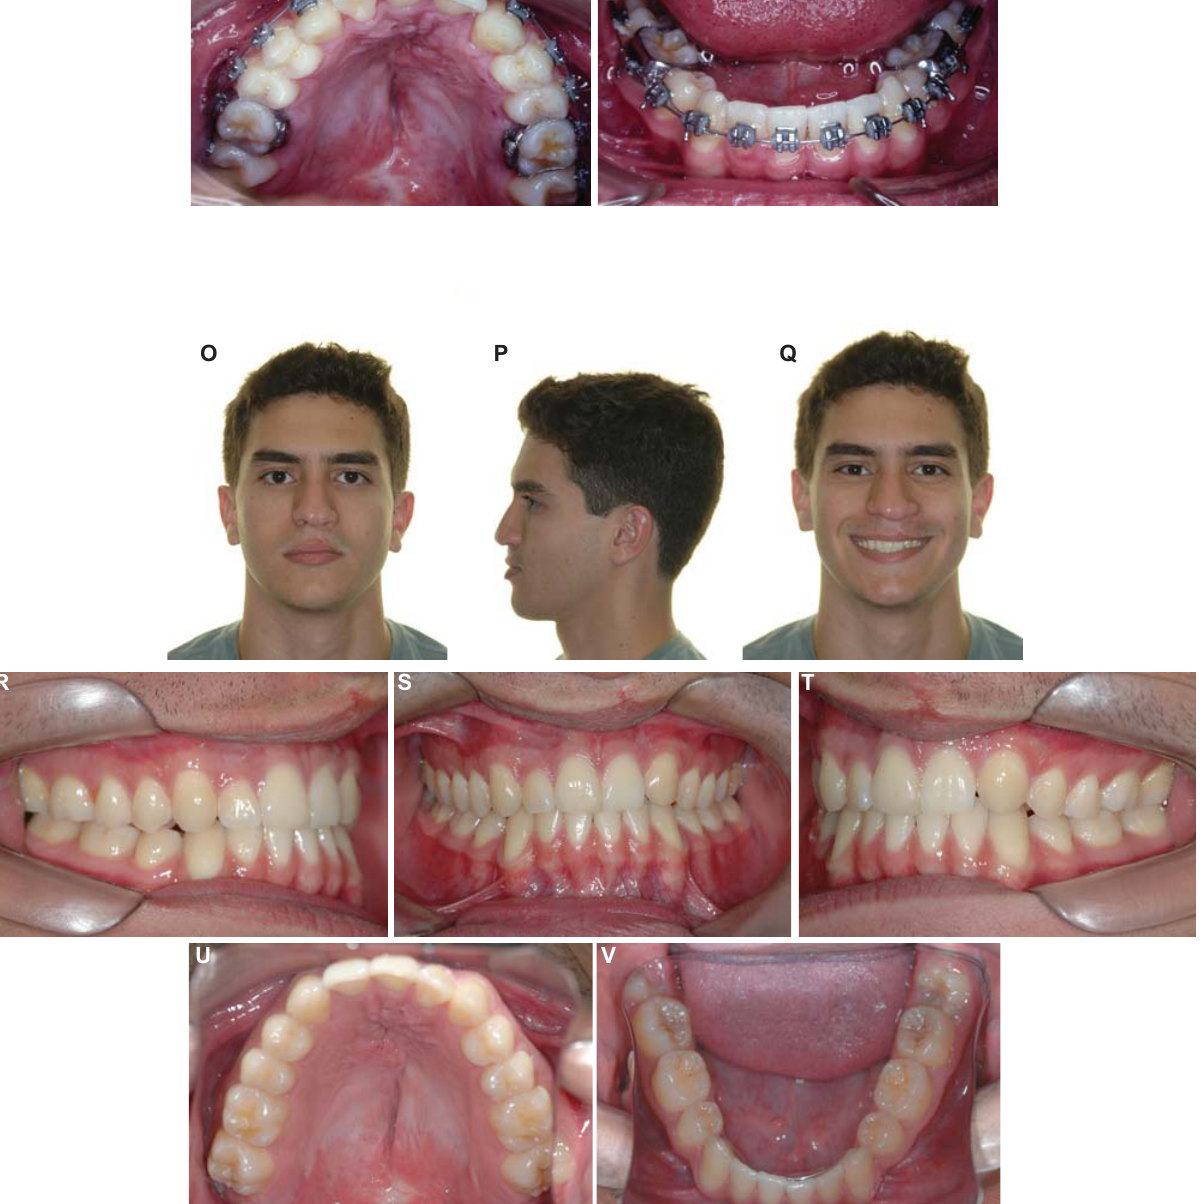
Figure 5- (cid:5)(cid:22)(cid:17)(cid:8)(cid:2)(cid:15)(cid:8)(cid:23)(cid:7)(cid:2)(cid:15)(cid:17)(cid:8)(cid:5)(cid:17)(cid:18)(cid:5)(cid:2)(cid:3)(cid:4)(cid:5)(cid:14)(cid:7)(cid:9)(cid:4)(cid:5)(cid:17)(cid:18)(cid:5)(cid:13)(cid:24)(cid:23)(cid:6)(cid:4)(cid:5)(cid:25)(cid:5)(cid:7)(cid:18)(cid:2)(cid:4)(cid:6)(cid:5)(cid:9)(cid:4)(cid:14)(cid:17)(cid:8)(cid:12)(cid:7)(cid:6)(cid:16)(cid:5)(cid:26)(cid:17)(cid:8)(cid:4)(cid:5)(cid:24)(cid:6)(cid:7)(cid:18)(cid:2)(cid:5)(cid:27)(cid:6)(cid:17)(cid:14)(cid:4)(cid:12)(cid:23)(cid:6)(cid:4)(cid:21)(cid:5)(cid:28)(cid:29)(cid:5)(cid:2)(cid:17)(cid:5)(cid:28)(cid:30)(cid:31)(cid:5)(cid:13)(cid:20)(cid:4)(cid:12)(cid:5)(cid:7)(cid:27)(cid:27)(cid:11)(cid:15)(cid:7)(cid:8)(cid:14)(cid:4)(cid:5)!(cid:15)(cid:2)(cid:3)(cid:5) (cid:23)(cid:8)(cid:14)(cid:6)(cid:17)(cid:9)(cid:9)(cid:15)(cid:8)(cid:24)(cid:5)(cid:26)(cid:15)(cid:2)(cid:4)(cid:5)(cid:19)(cid:4)(cid:14)(cid:3)(cid:7)(cid:8)(cid:15)(cid:14)(cid:9)(cid:5)(cid:7)(cid:8)(cid:12)(cid:5)(cid:23)(cid:9)(cid:4)(cid:5)(cid:17)(cid:18)(cid:5)(cid:2)(cid:3)(cid:4)(cid:5)(cid:14)(cid:7)(cid:8)(cid:15)(cid:8)(cid:4)(cid:5)(cid:7)(cid:9)(cid:5)(cid:11)(cid:7)(cid:2)(cid:4)(cid:6)(cid:7)(cid:11)(cid:5)(cid:15)(cid:8)(cid:14)(cid:15)(cid:9)(cid:17)(cid:6)(cid:21)(cid:5)(cid:28)"(cid:5)(cid:2)(cid:17)(cid:5)(cid:28)#(cid:31)(cid:5)(cid:7)(cid:18)(cid:2)(cid:4)(cid:6)(cid:5)(cid:13)(cid:20)(cid:4)(cid:12)(cid:5)(cid:7)(cid:27)(cid:27)(cid:11)(cid:15)(cid:7)(cid:8)(cid:14)(cid:4)(cid:5)(cid:6)(cid:4)(cid:19)(cid:17)(cid:10)(cid:7)(cid:11)(cid:5)$(cid:27)(cid:7)(cid:6)(cid:4)(cid:8)(cid:2)(cid:9)(cid:5) authorized the publication of these